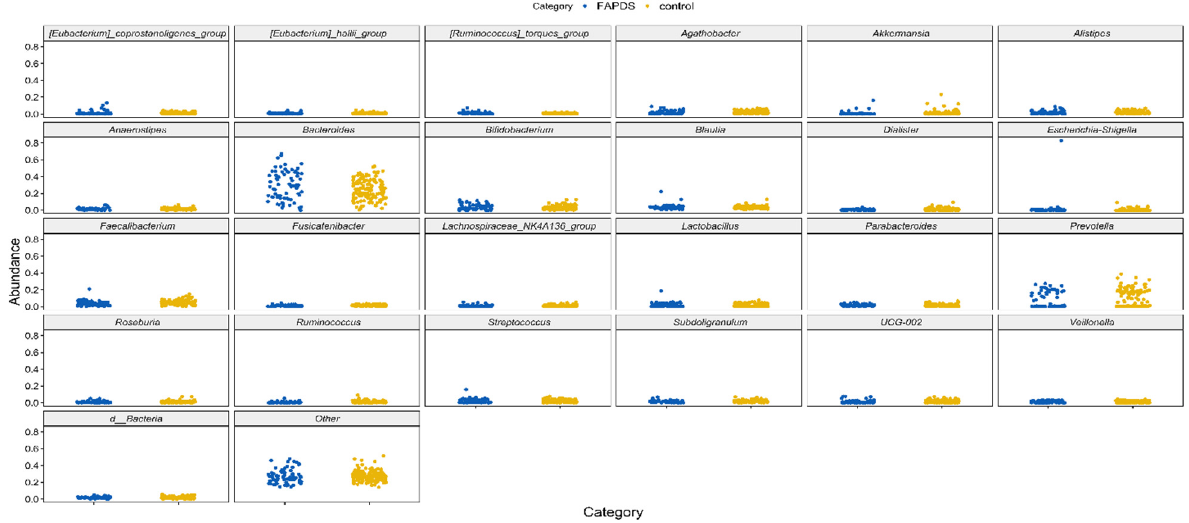
Figure 2. The relative abundances of the most abundant bacterial taxa in the study.